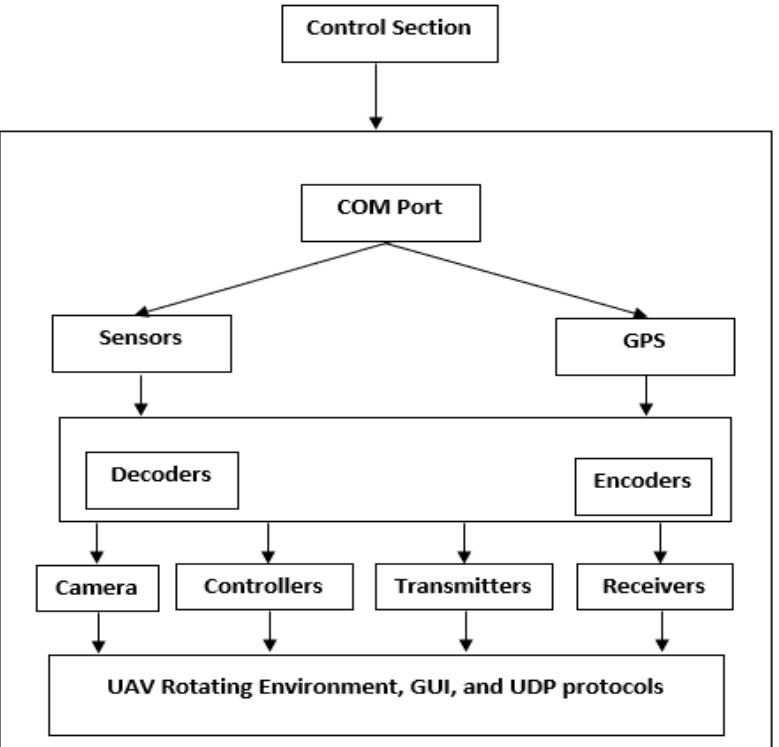
Figure 2. A UAV architecture composition.